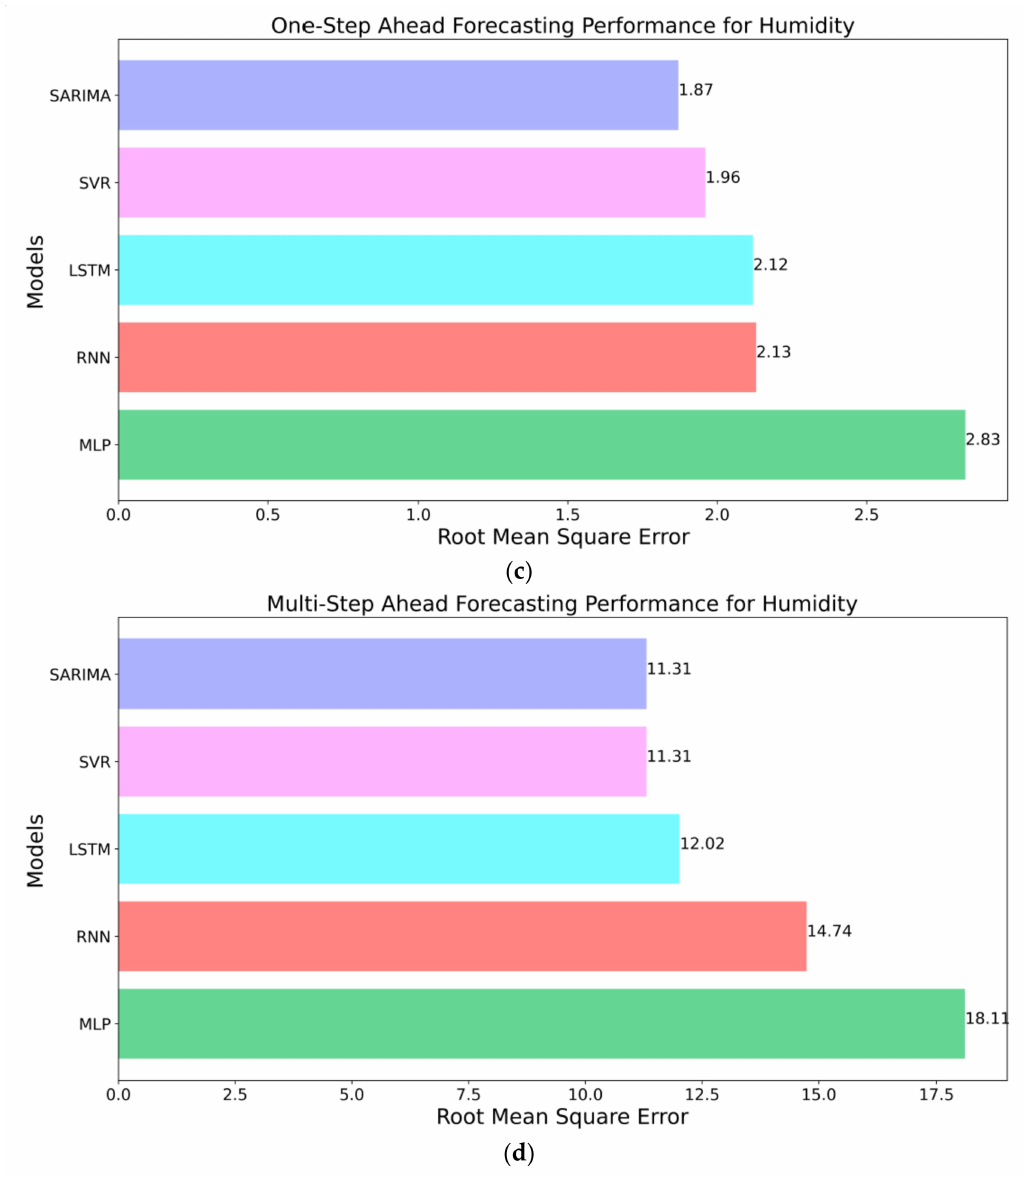
Figure 10. Best performing models and associated RMSE values for ( a ) One-step ahead Temperature ( b ) Multi-step ahead Temperature ( c ) One-step ahead Humidity ( d ) Multi-step ahead Humidity ( top-to-bottom